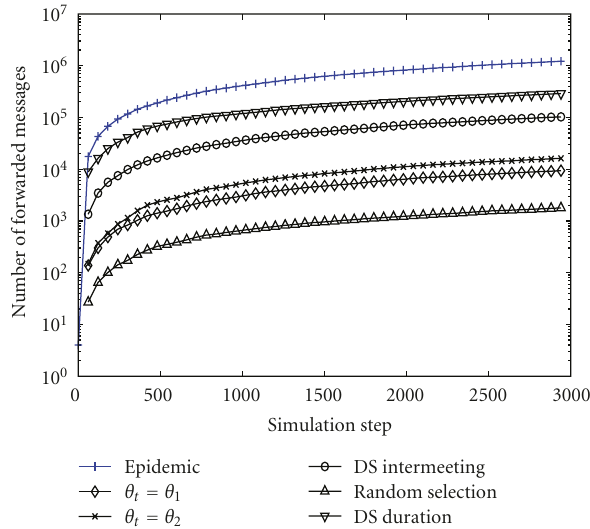
Figure 7: Number of forwarded messages under di ff erent routing schemes and di ff erent threshold values.